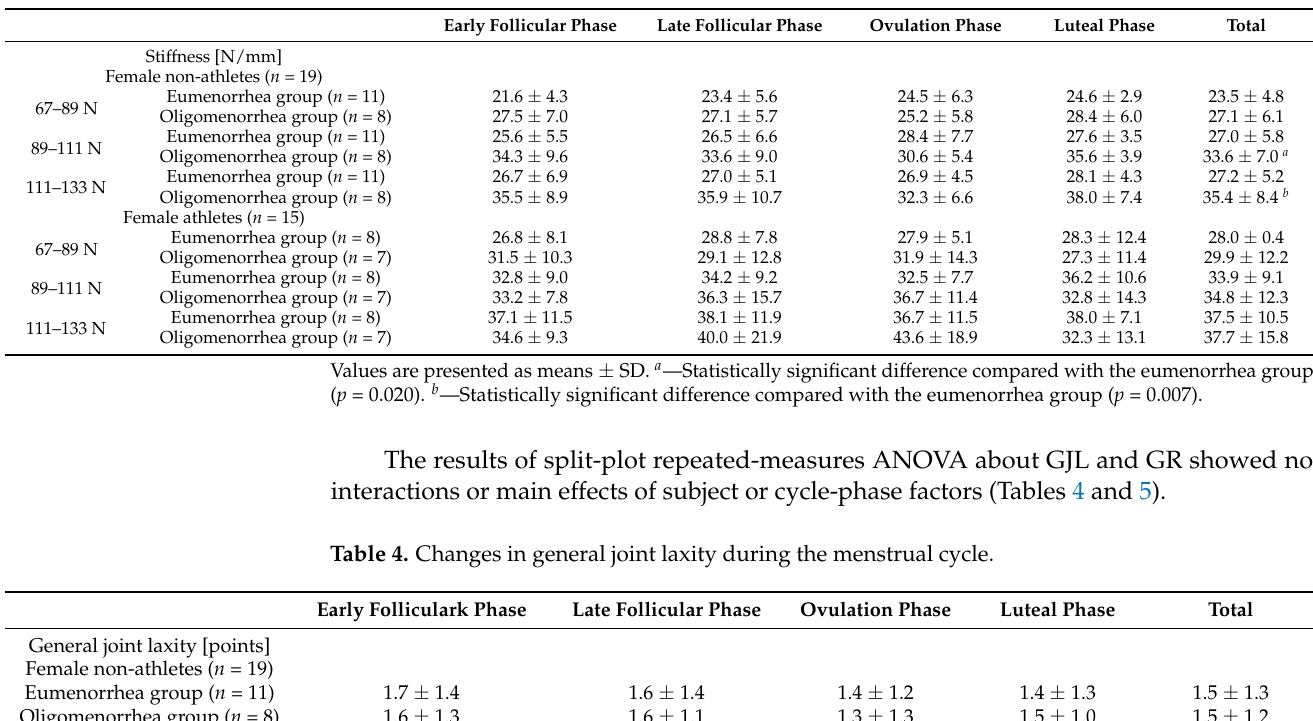
Table 3. Changes in stiffness during the menstrual cycle.